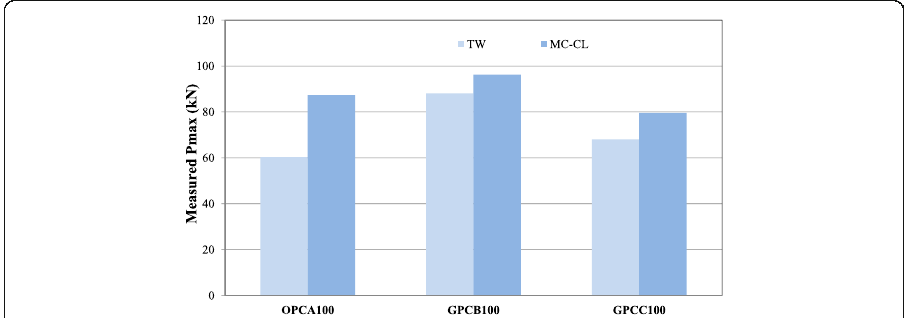
Fig. 11 Loading capacity of OPCA100, GPCB100, and GPCC100 samples under ACS with different aggressive media